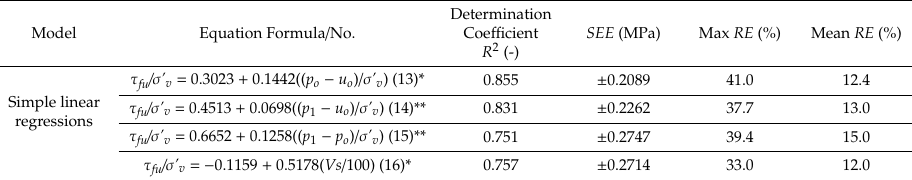
Table 6. Comparison of the analyzed simple linear regression